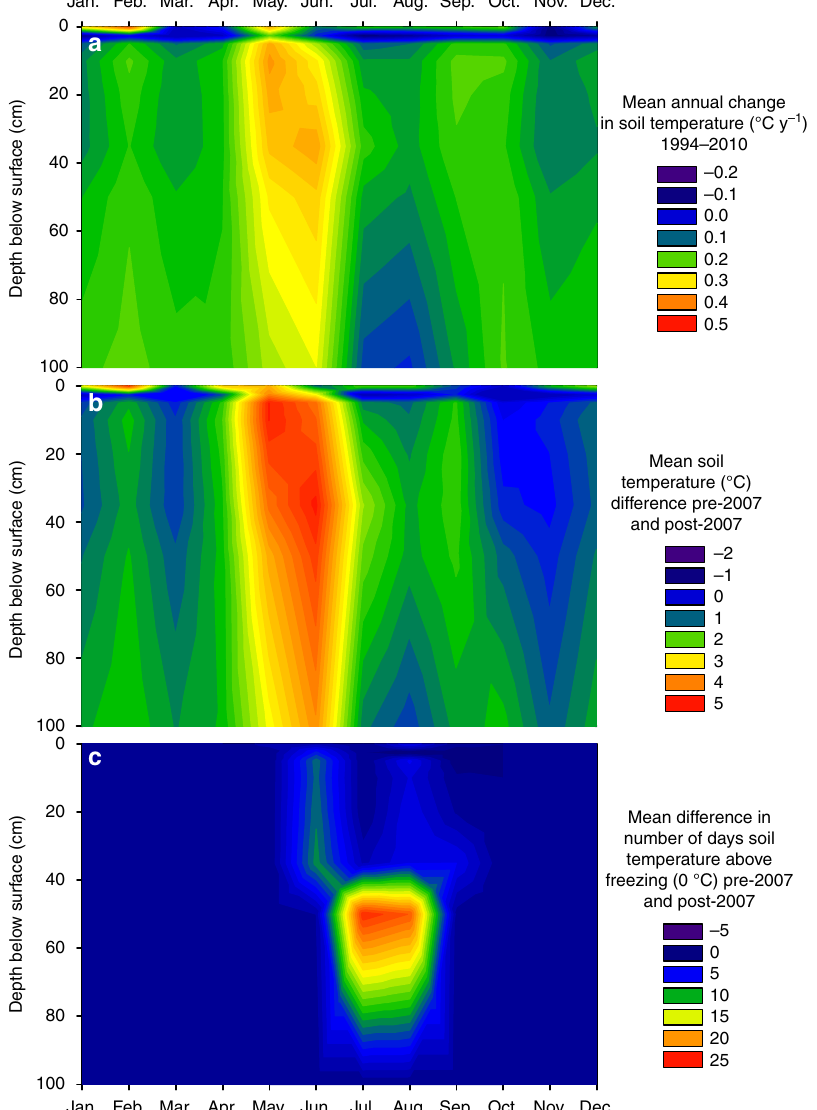
Fig. 2 Changes in air and soil temperatures in the Lake Hazen watershed. a Mean annual change in monthly soil temperature (°C y − 1 ) for the period 1994 – 2010. b Difference in mean monthly soil temperature (°C) between the periods of 2007 – 2010 and 1994 – 2006, indicating that soil